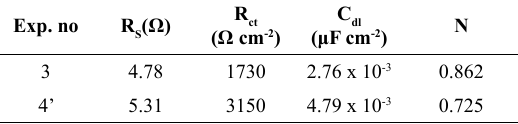
Figure 8. Nyquist diagrams for Co-rich Cu-Co coating/carbon steel substrates immersed in NaCl 0.5 mol L -1 for 1 h and 24 h. (A) Experiment 3 (j = 15 A m -2 , using DC) and (B) Experiment 4’ = 40 A m -2 , using SPC) (j m and C values obtained by simulating the EIS data Table 5. R ct dl (Figure 8) using the equivalent circuit presented in Figure